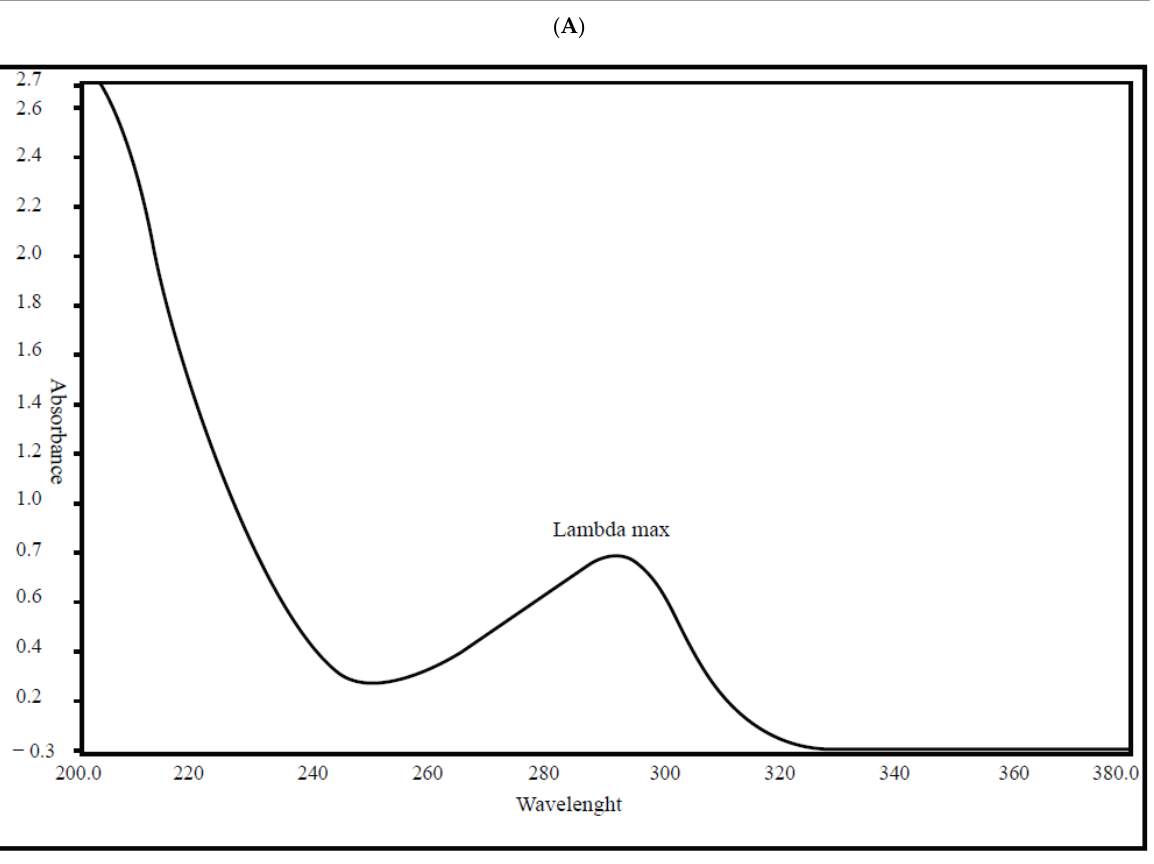
Figure 2. ( A ) The absorbance profile of meloxicam in the 200–400 nm range. ( B ) The absorbance profile of pantoprazole in the range of 200–400 nm. The best chromatographic conditions for simultaneously measuring meloxicam and pantoprazole were based on each drug’s resolution and retention time. The mixture of the mobile phase at a pH of 3.4, as appears in Table 2, provided the best resolution. All of the excipients used in the formula were compatible with both drugs, as is ap- parent in FTIR and DSC studies. 3.2. FTIR of Pantoprazole and Meloxicam Tests using Fourier Transform Infrared Spectroscopy (FTIR) for the formerly men- tioned drugs match with their fingerprints and agree with what is seen in the literature [36,37]. The pantoprazole FTIR spectra revealed absorption bands in the range of 3000 to 3500 cm − 1 , with significant O-H and C-H absorption bands; the range of 1800 to 1500 cm − 1 exhibits C=C and C=N absorption bands. On the other hand, bands can be seen at about 3290 cm − 1 (the stretching vibration of an amide group (N–H)), 2917 cm − 1 (the stretching vibration of an alkyl group), 1622 cm − 1 (the stretching mode of an amide group), as can a sharp band at 1522 cm − 1 (C=C aromatic stretching vibration). The meloxicam’s character- istic bands are at 1384 and 1172 cm − 1 (for two sulphonyl groups (S=O stretching vibration)) [38]. The FTIR of pantoprazole and meloxicam appear in Figure 3A,B, respectively.